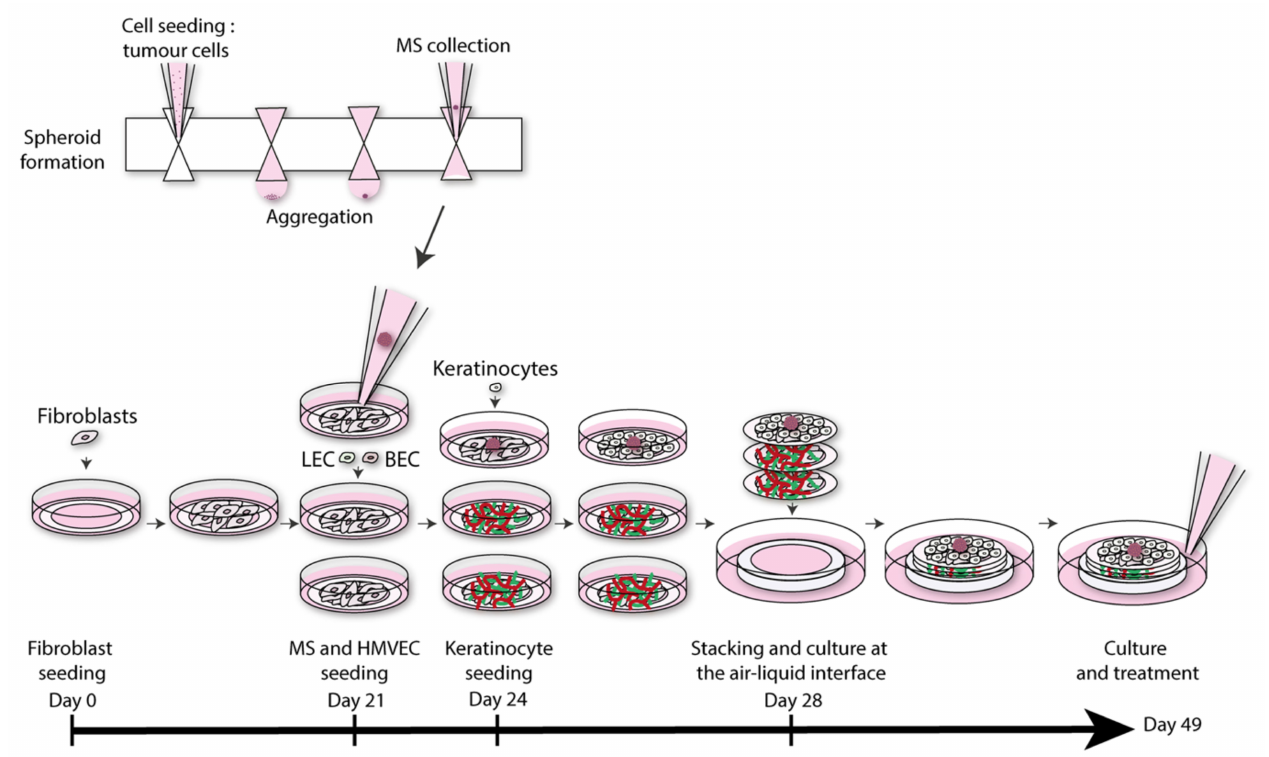
Figure 4. Schematic showing construction of a melanoma model with vasculature and lymphatic vessels. Adapted from [86], published by Nature Portfolio,